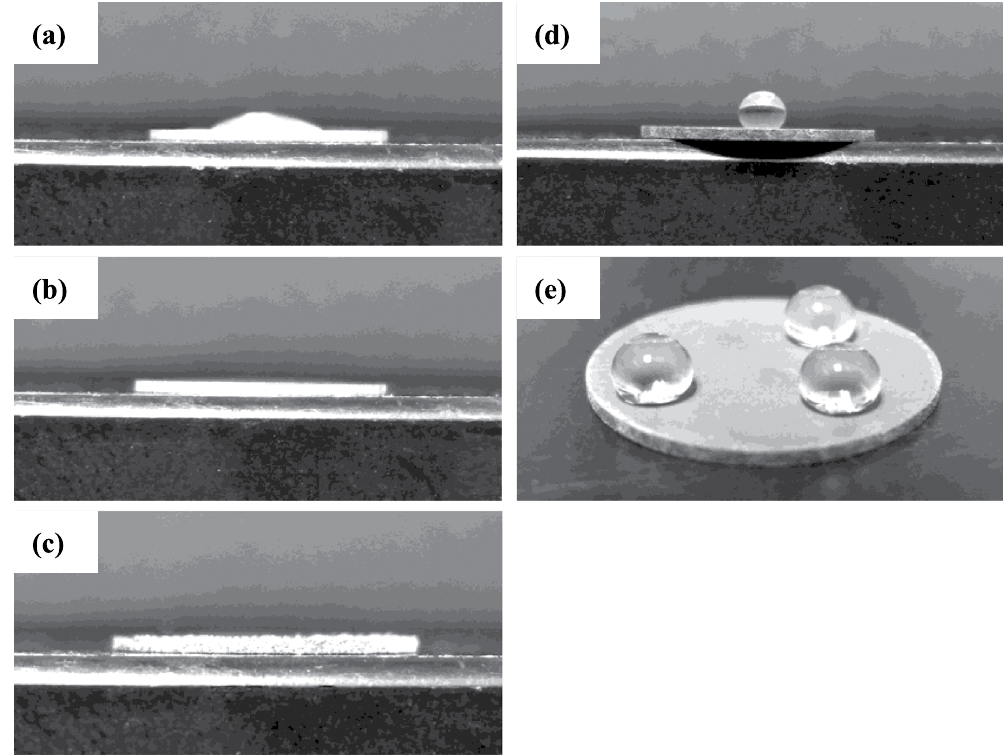
Figure 3. Hydrophilicity of the ( a ) uncoated AZ61 Mg alloy, ( b ) AZ61-AP, ( c ) AP-HT and ( d ) HT-SAM. ( e ) Multi-points contact angle of the water droplets on the